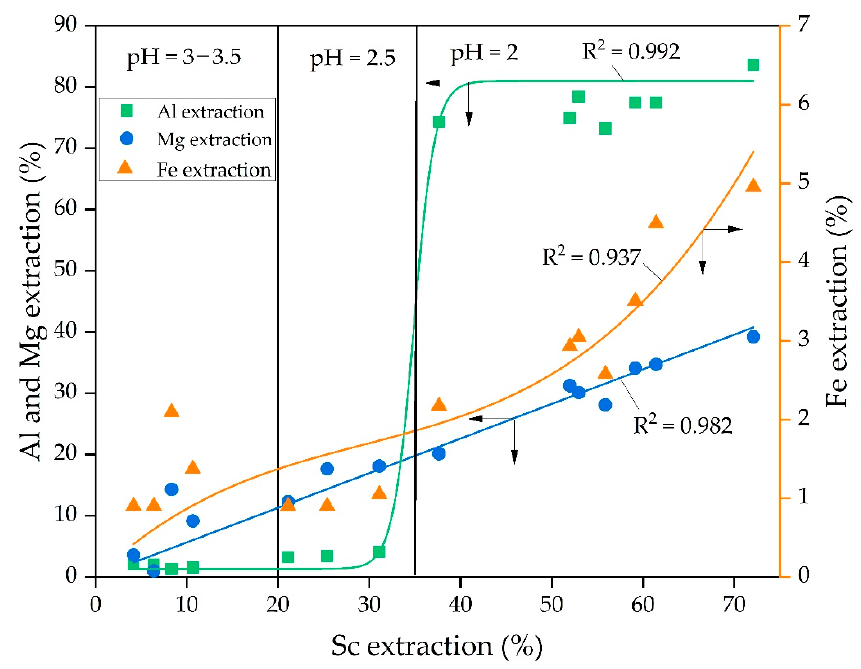
Figure 8. Dependence of the Al, Mg, and Fe extraction on Sc extraction and the fitting of the experimental data obtained at different pH value.